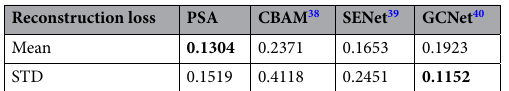
Table 4. Performance comparison of various attention mechanisms. Significant values are in bold.